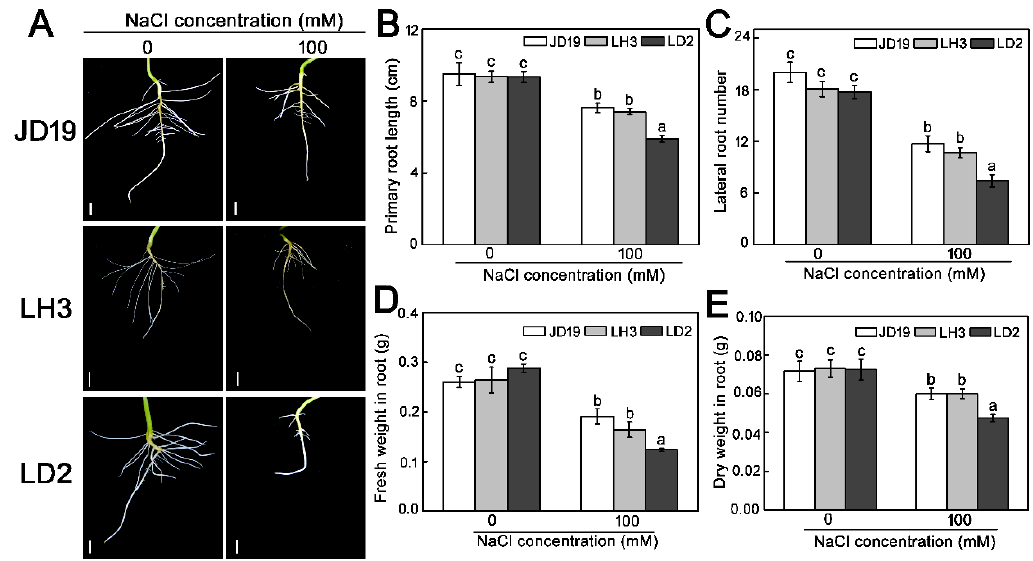
Figure 1. Root phenotype ( A ), primary root length ( B ), lateral root number ( C ), fresh weight ( D ), and dry weight ( E ) of three soybean cultivars under 100 mM NaCl treatment. Bar: 1 cm. Data are means ± SE (n = 3). Different letters indicate significant difference at p < 0.05.